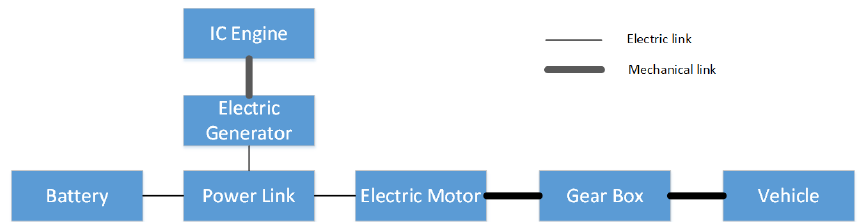
Figure 4. Series hybrid configuration.